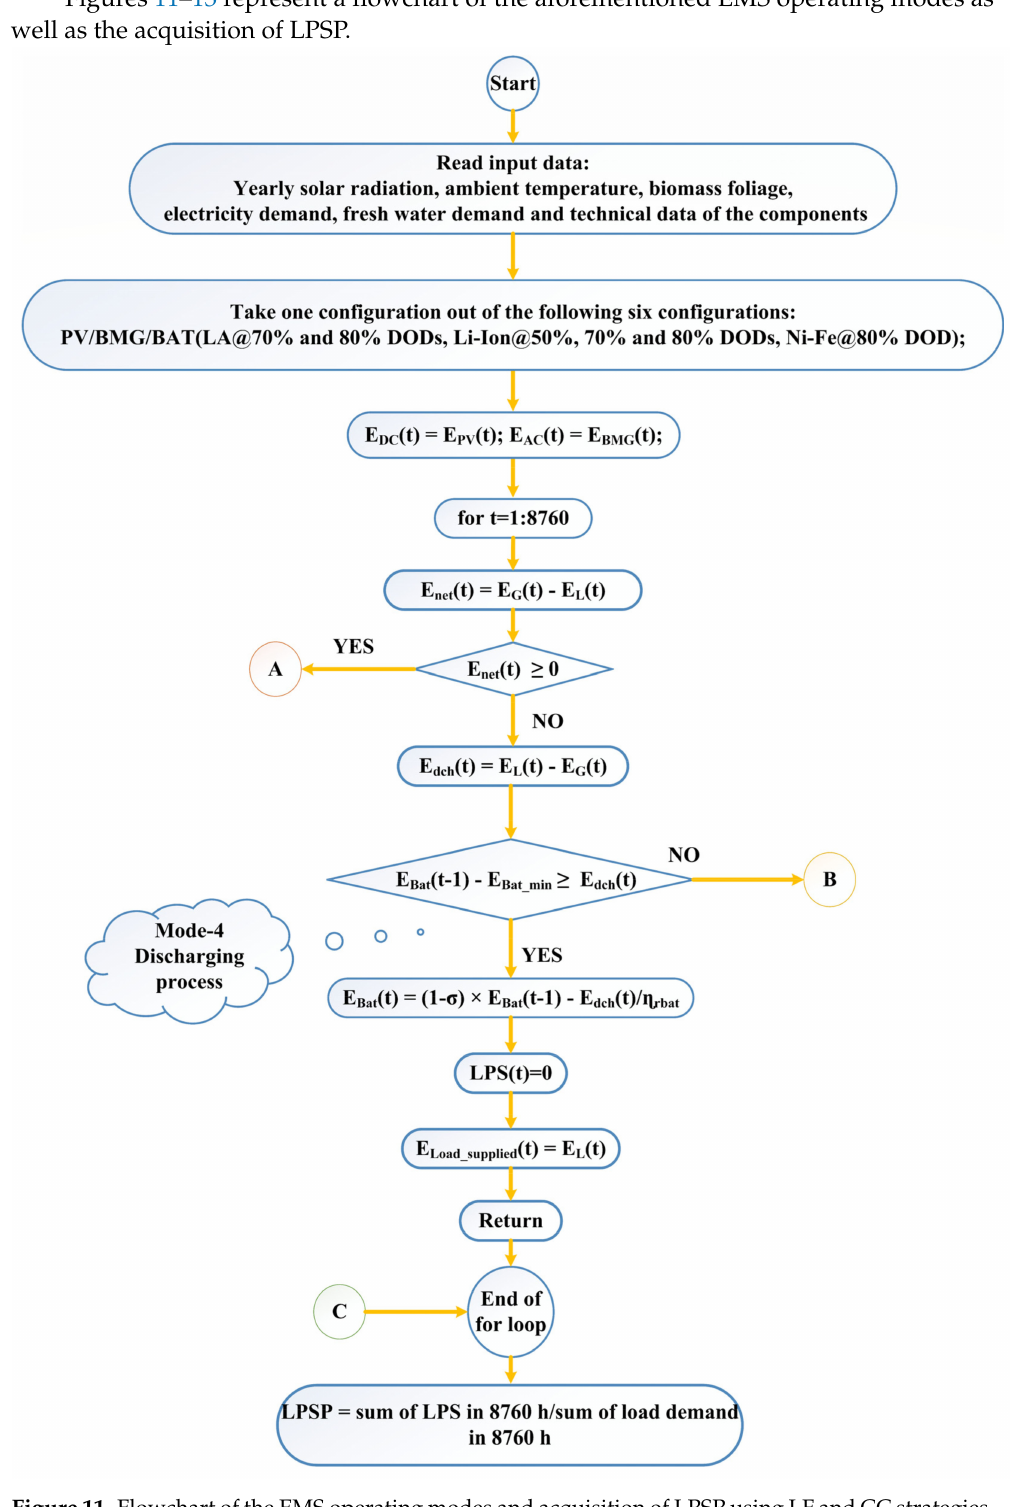
Figure 11. Flowchart of the EMS operating modes and acquisition of LPSP using LF and CC